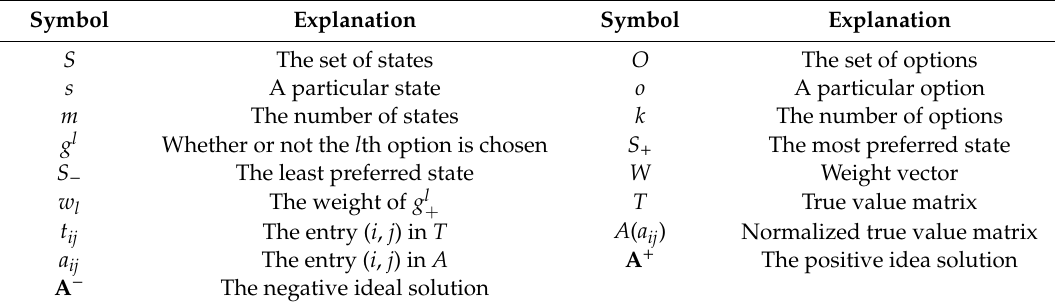
Table 1. Symbols and their